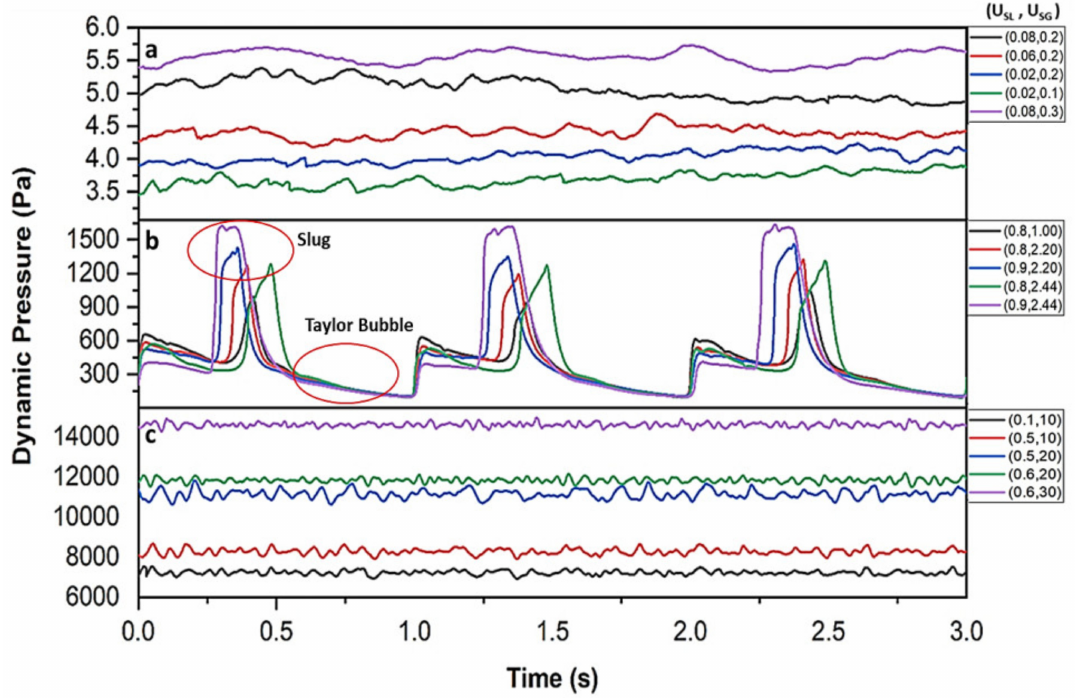
Figure 8. Pressure fluctuating signals of different flow regimes: ( a ) stratified, ( b ) slug, and ( c ) annular.